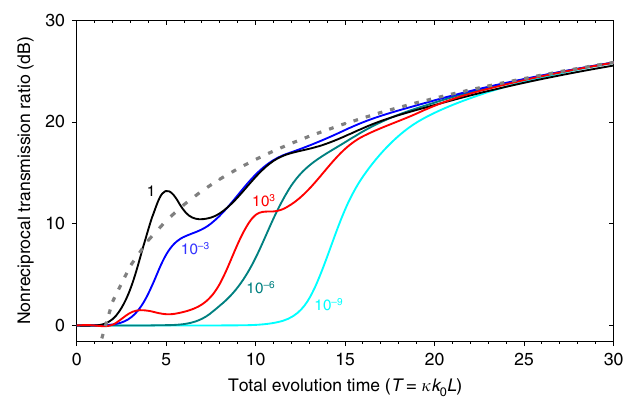
Figure 5 | Dependence of the nonreciprocal transmission ratio on the total evolution-time parameter T . Each curve shows the NTR for a given incident intensity to saturation intensity ratio I 0 / I S as indicated by a value in the same colour as the corresponding curve. The grey dashed curve represents an a T 2 curve fit following equation